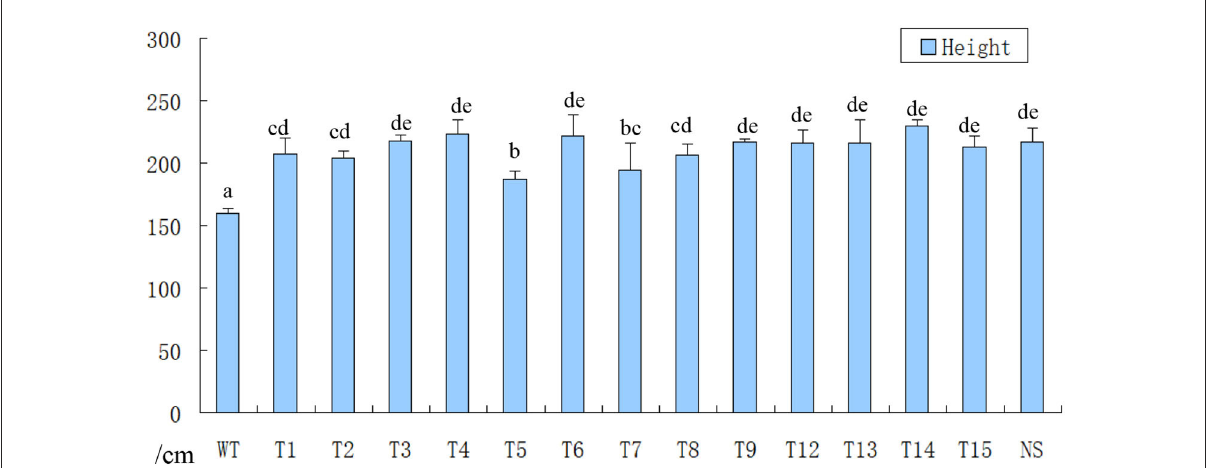
FIGURE7 Height measurement of axillary bud propagation shoots (Ten months after transplant in green house). WT, infected wild-type shoots were significantly shorter than all transgenic shoots; T1–T15, infected transgenic shoots attained greater heights than wild-type shoots, and some transgenic shoots were shorter than normal shoots; NS, normal shoots (without SCSMV infection).